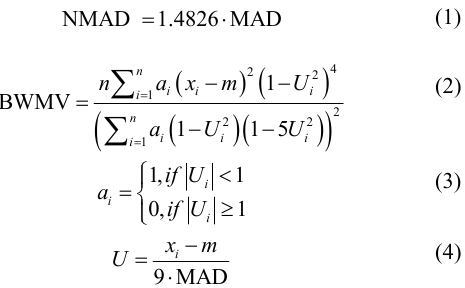
Figure 6. Extramural buildings: different views of the 4D modelling of the Alcázar Gate surroundings, mid-nineteen deviation (NMAD) and the square root of the biweight midvariance (BWMV) (Nocerino et al., 2017).